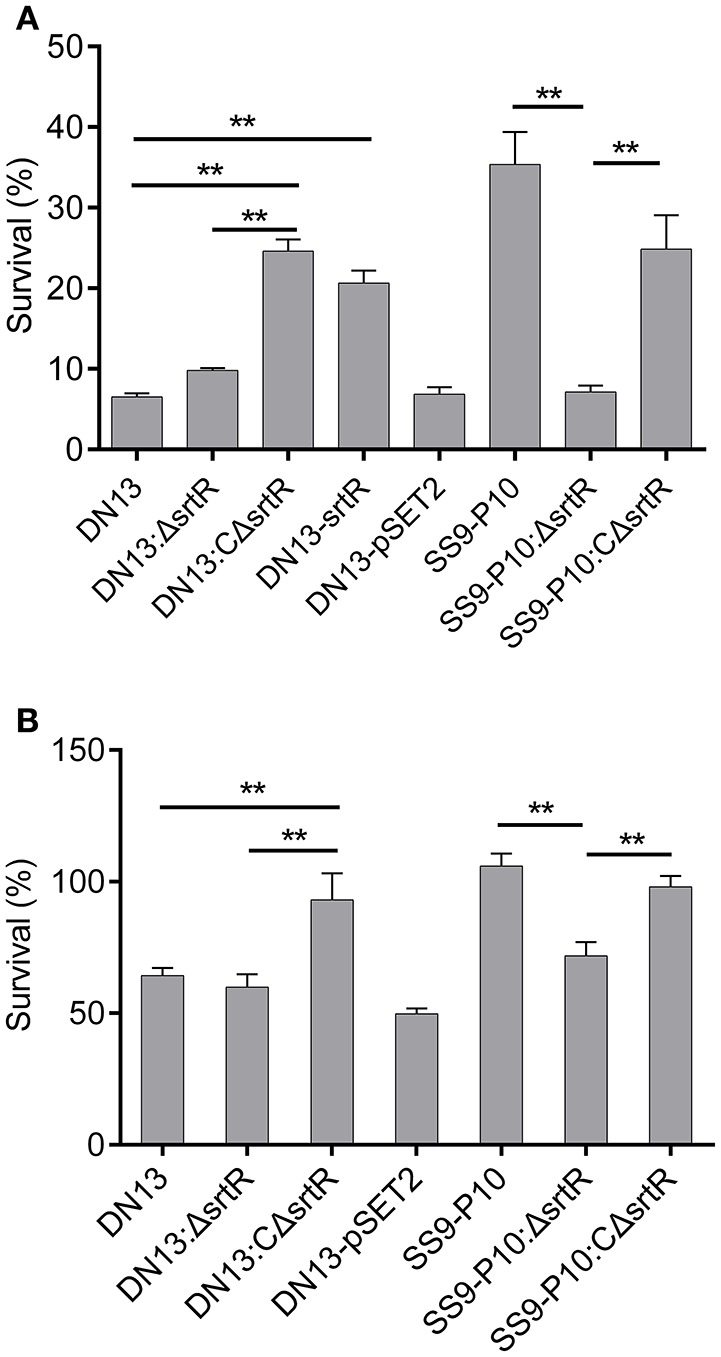
SrtR contributes to oxidant and high-temperature tolerance in Streptococcus suis. The role of srtR was evaluated by comparing the same background strains (DN13, DN13:ΔsrtR vs. DN13:CΔsrtR and DN13- srtR, SS9-P10:ΔsrtR vs. SS9-P10 as well as SS9-P10:CΔsrtR) with or without functional srtR. All experiments in this part were conducted in duplicate and repeated three times. Values were expressed as mean percentages with standard deviation. One-way analysis of variance (ANOVA) with Kruskal-Wallis test was used to assess oxidative and thermal stress assays. Plasmid-encoded srtR significantly increased resistance to H2O2 challenge in SrtR-deficient strains; DN13, DN13:ΔsrtR, and SS9-P10-ΔsrtR (A). Growth at 42°C was significantly improved by the introduction of plasmid-encoded srtR into SrtR-deficient strains; DN13:ΔsrtR, and SS9-P10-ΔsrtR (B). Survival data of DN13 and SS9-P10 at 42°C were identical to those displayed in Figure 2B, as thermal tolerance assays with DN13, the mouse-adapted strains, and engineered strains were conducted at the same time. **P < 0.01.